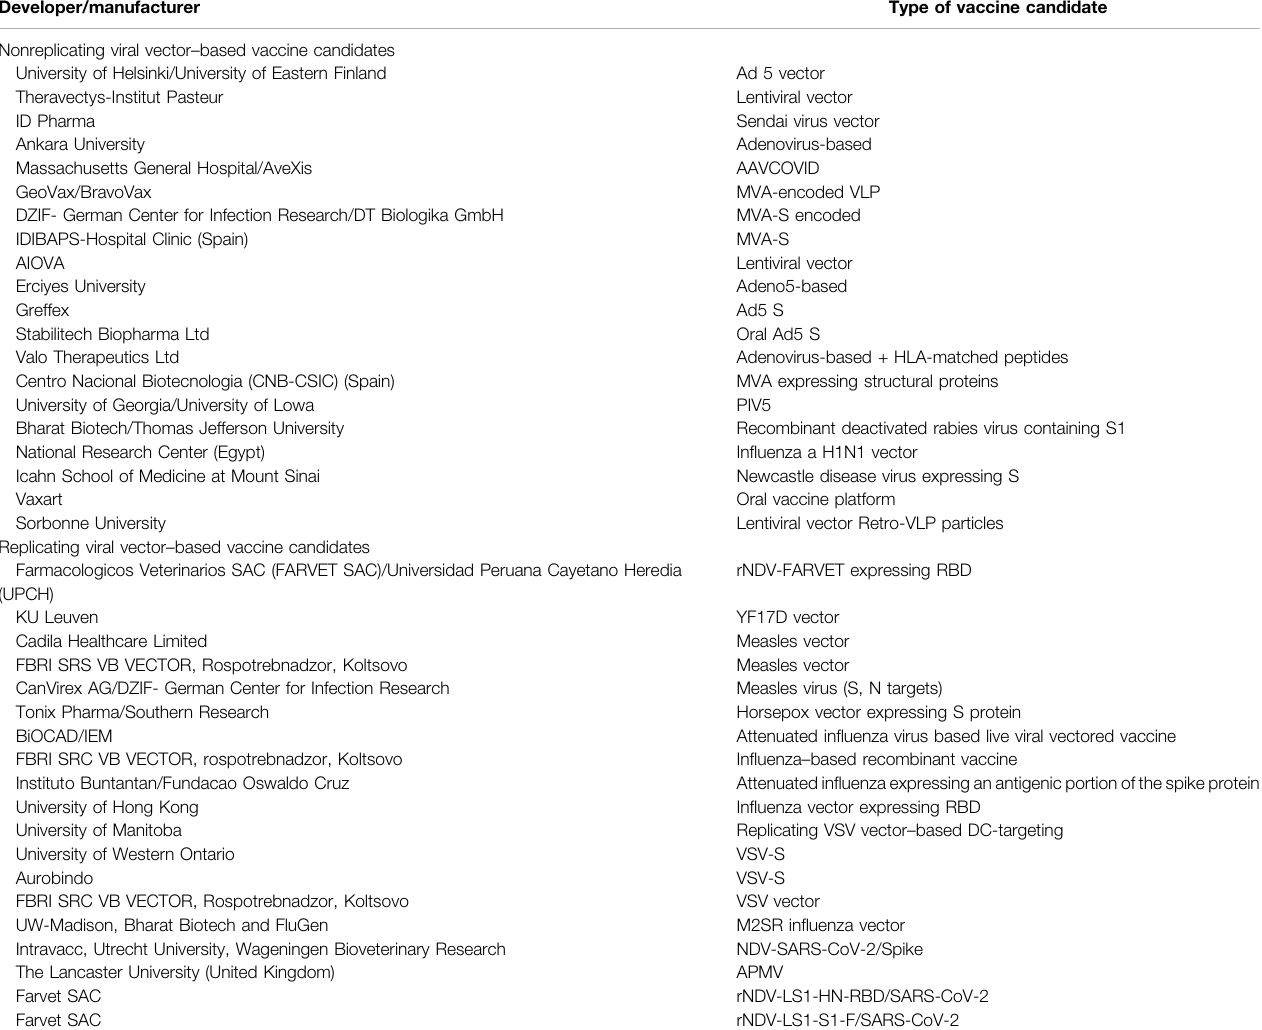
TABLE 2 | List of viral vector – based vaccine candidates under preclinical evaluation (WHO, 2021).